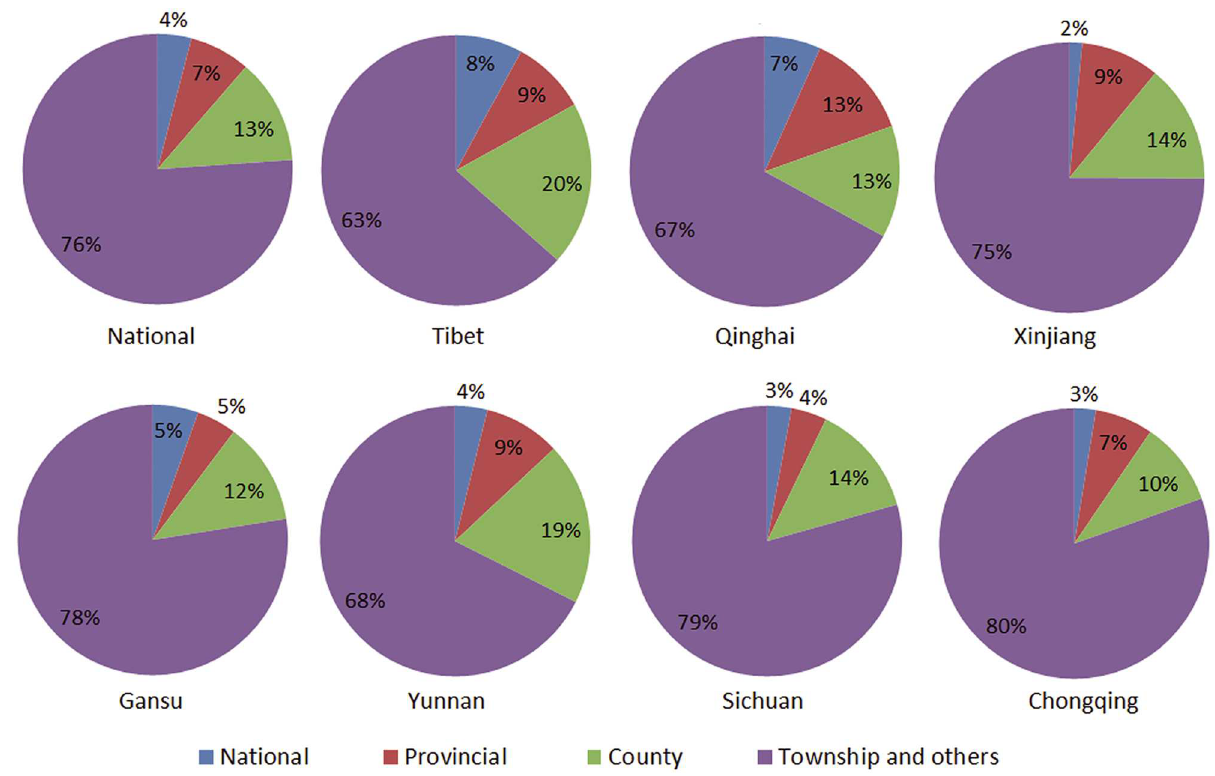
Fig 2. Proportions of road types among high-altitude provinces in 2013.